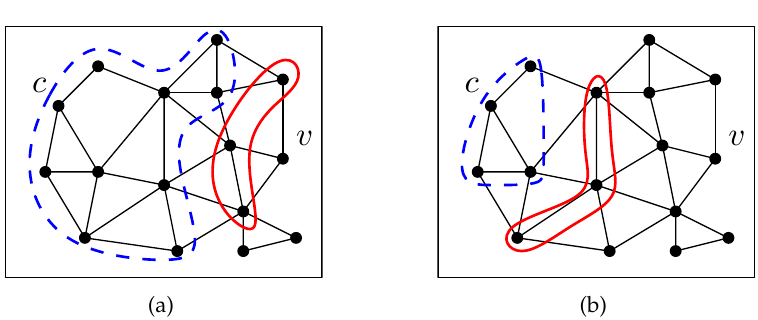
Figure 7: The ( c, v ) -separator (red) divides the graph into at least two connected components. The component of c (dashed, blue) in (b) is more likely to offer a Constraint (14) than the one in